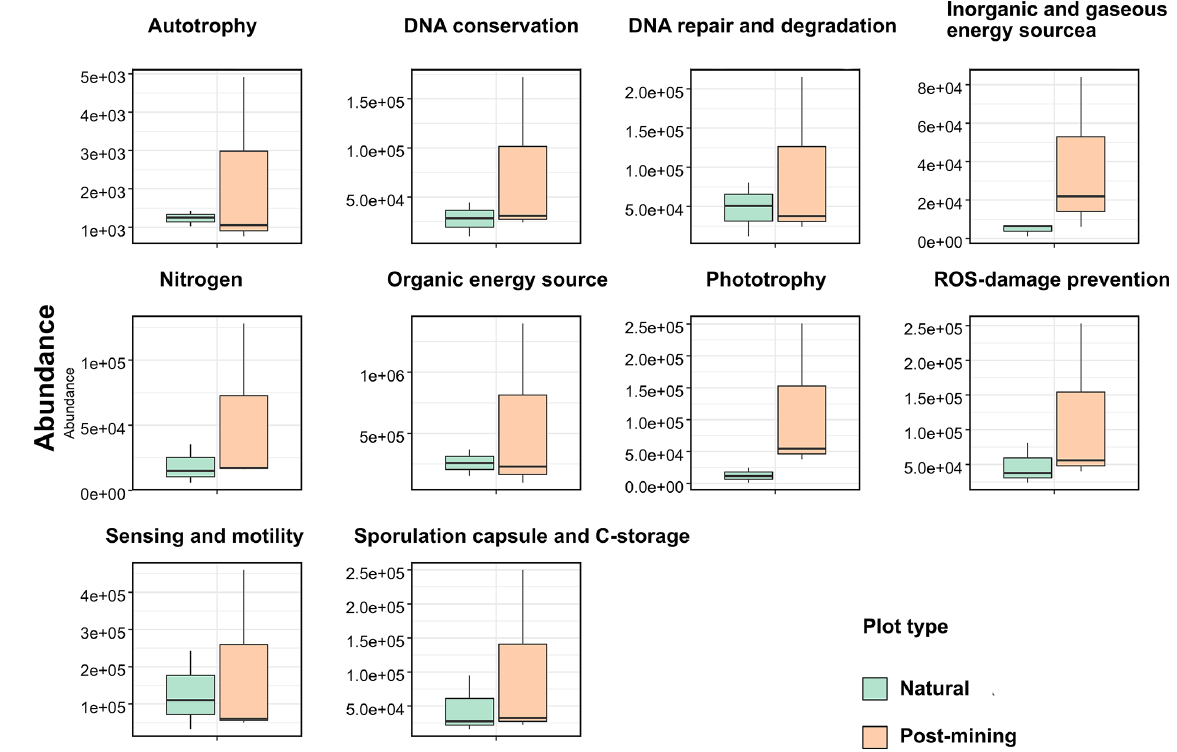
Figure 6. Boxplot of functional predictions. The y axis represents functional gene abundances. The line represents the median, and the whiskers represent the